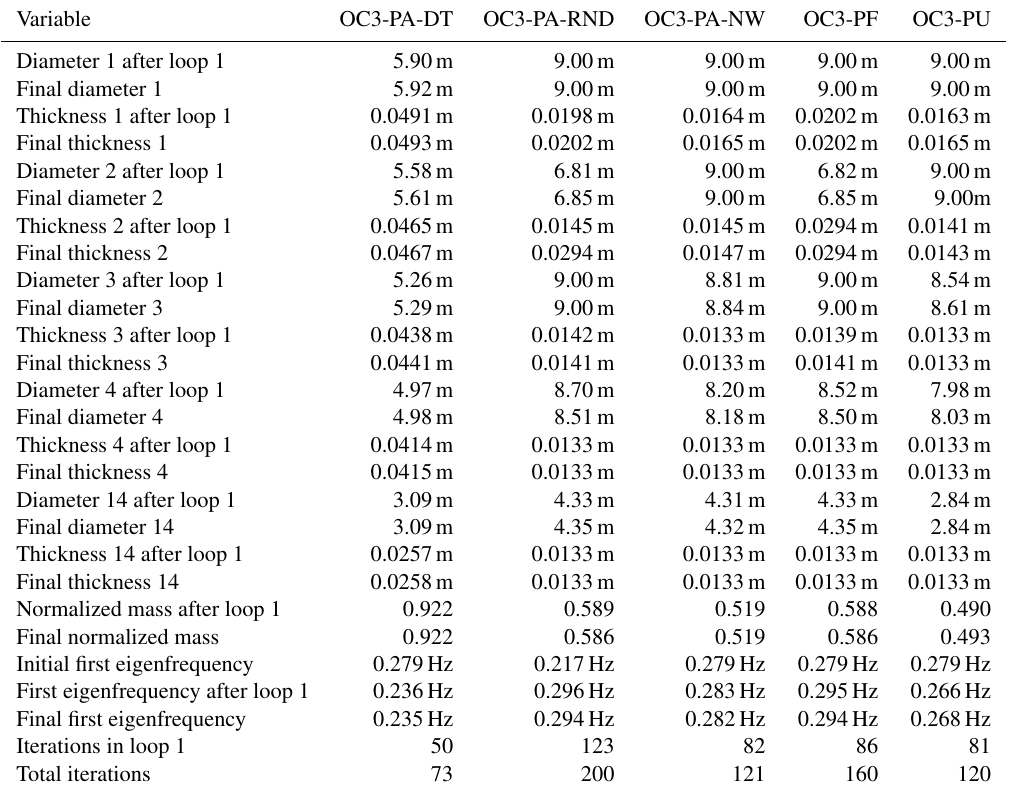
Table 8. Selected summary results of cases OC3-PA-DT, OC3-PA-RND, OC3-PA-NW, OC3-PF and OC3-PU. Design variable numbers run from 1 (bottom element) to 14 (top